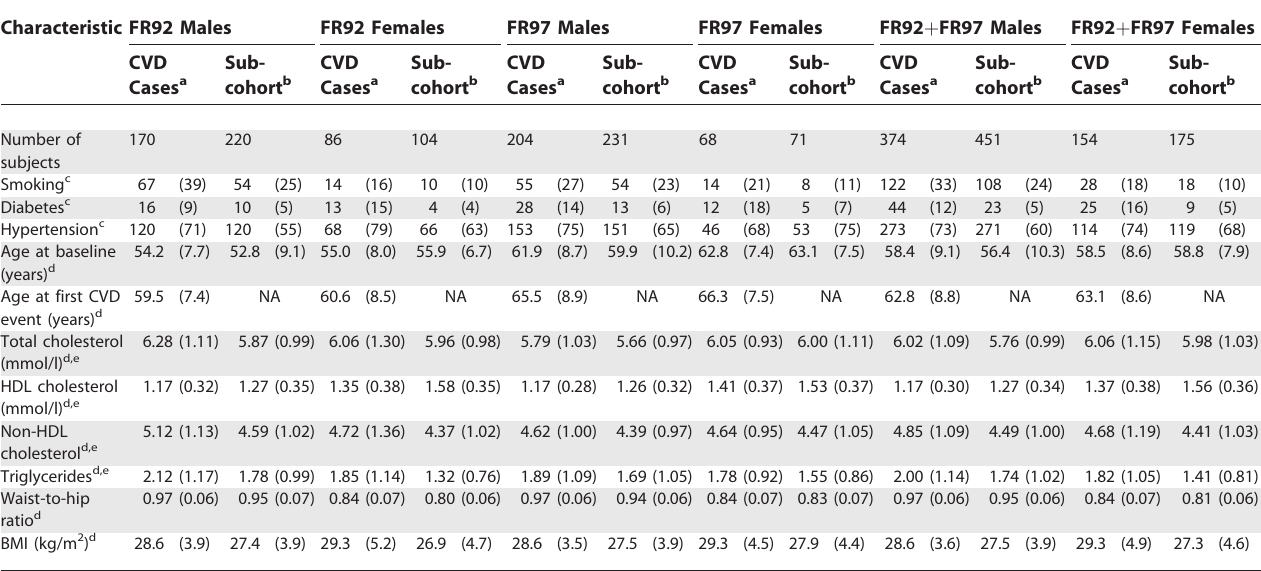
Table 2. Baseline Characteristics of Cardiovascular Cases and Subcohort Characteristic FR92 Males